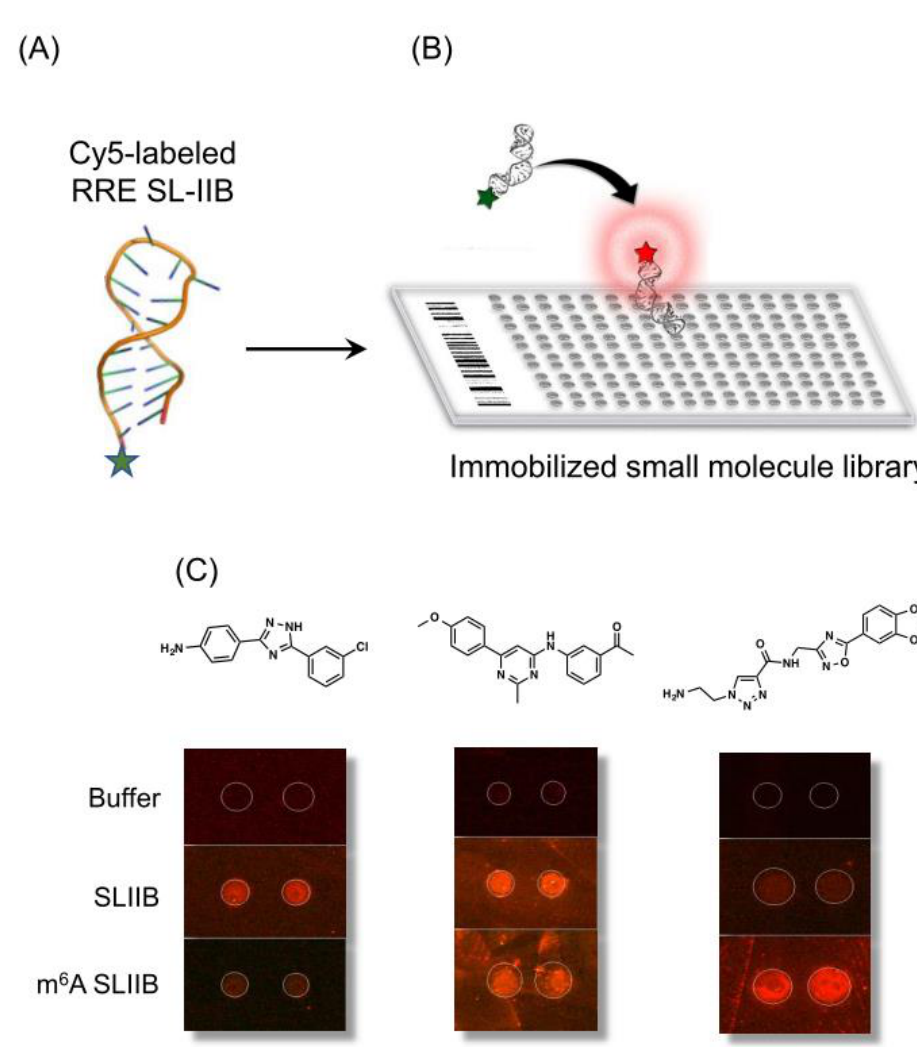
Figure 7. Time-dependent conformational rearrangement of the HIV-2 RRE. Analyses were performed on a 216 nt RRE derived from HIV-2 ROD by in vitro transcription. ( A ) Native gel electrophoresis as a function of incubation time indicates the HIV-2 RRE comprises a mixture of “open”, “intermediate”, and “closed” conformers ( A – C , respectively) at short incubation times and whose ratio varies with time, with the closed conformer ultimately predominating. ( B ) SHAPE-derived conformations of the open, intermediate, and closed HIV-2 RRE forms, respectively. Secondary structural motifs are indicated and color-coded as follows: SL-I, red; S-IIA, dark green, SL-IIB, -IIC and adjacent connecting loops, magenta; SL-III, yellow; SL-IV, blue; SL-V, orange. Modified from Reference [64].